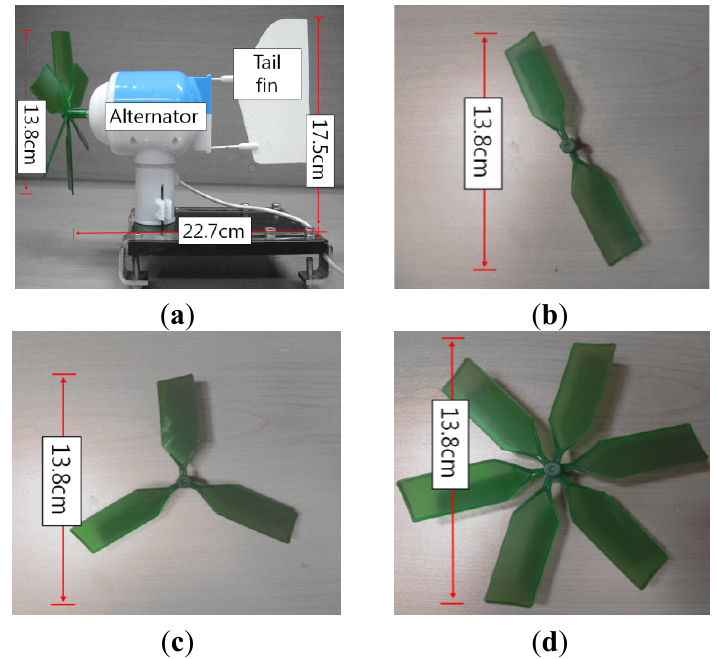
Figure 7. Horizontal-axis wind turbine: ( a ) side view of the wind turbine; ( b ) two-blade propeller; ( c ) three-blade propeller; ( d ) six-blade propeller.